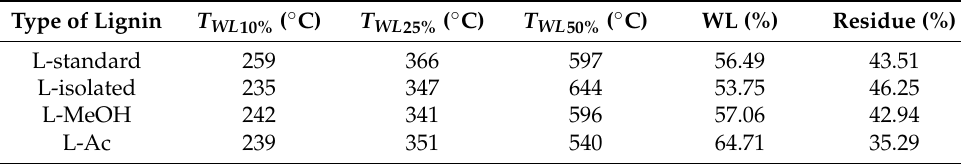
Table 3. Degradation temperature and weight loss of lignin detected by TGA.